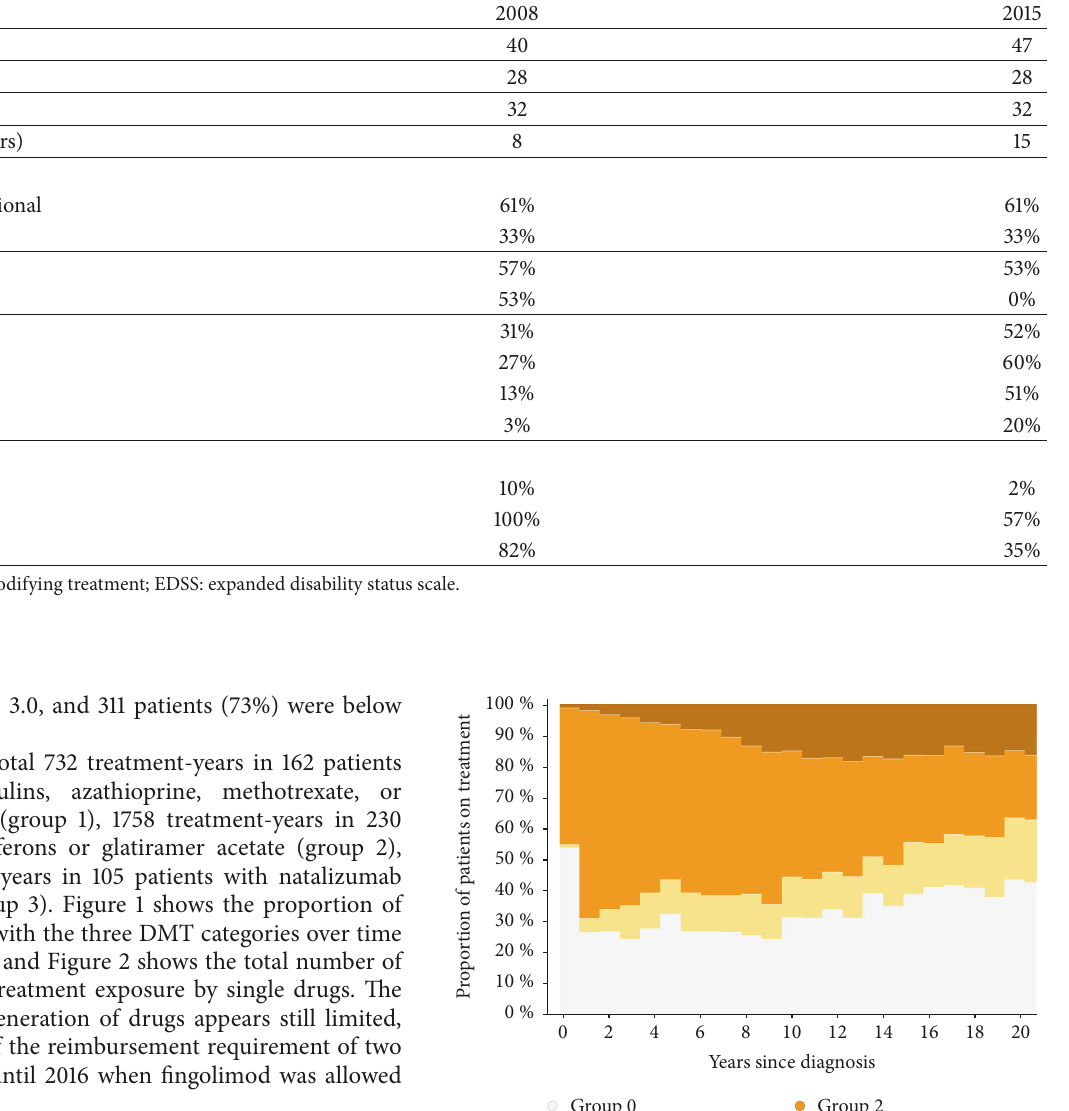
Table 1: Demographics and resource consumption ( N = 426).